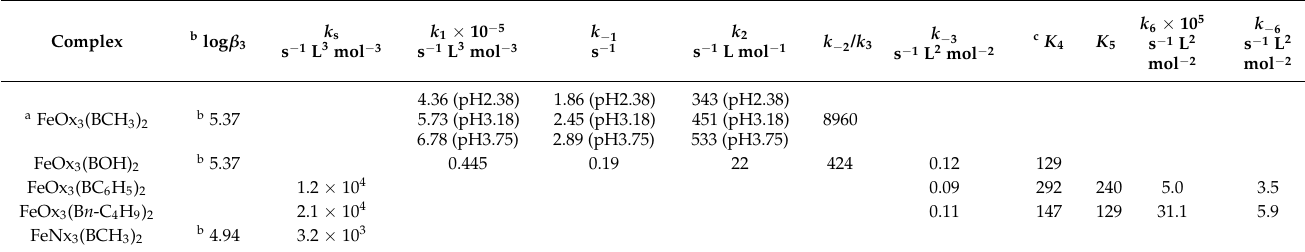
Table 1. Kinetic and thermodynamic parameters of the template synthesis and the acidic decomposition reactions of the methylboron-capped iron(II) tris-octoximate FeOx 3 (BCH 3 ) 2 ( 5 ), and those for its tris-nioximate ( 4 ) [6] and hydroxy-, phenyl- and n -butylboron-capped tris-octoximate [1]